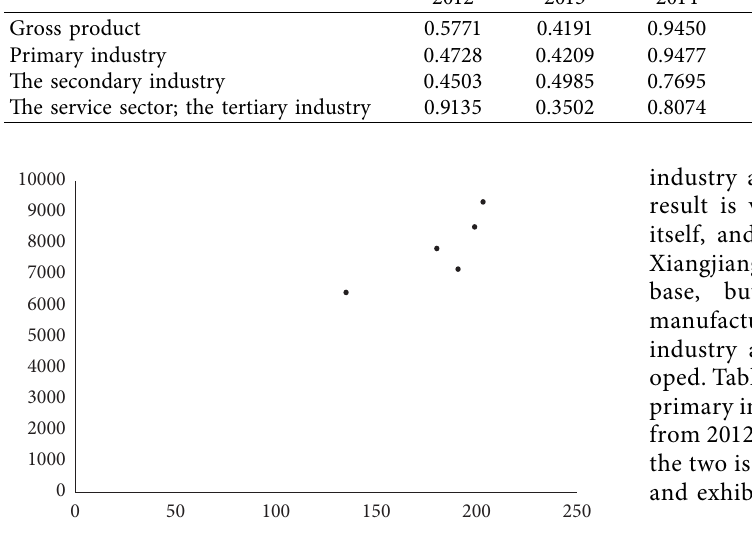
Figure 4: Changsha convention and exhibition industry and the relationship between the total outputs of the scattered map.